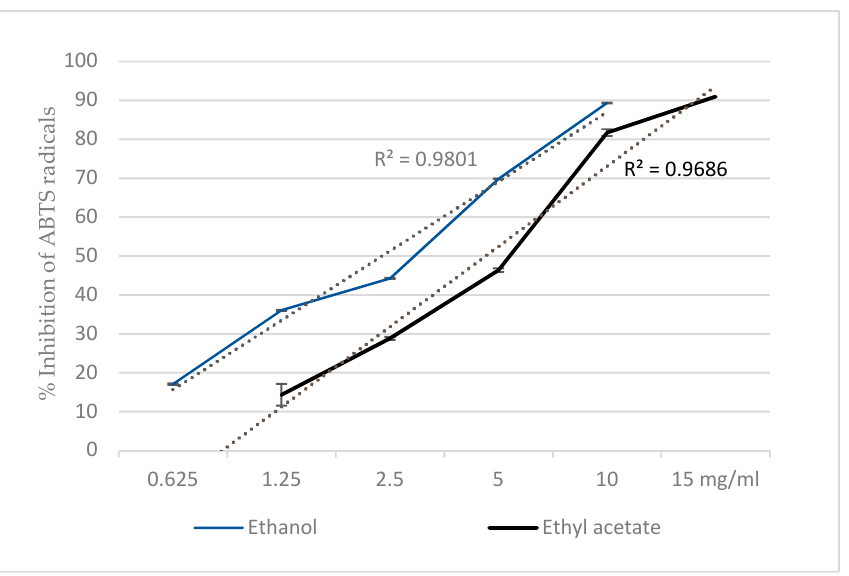
Figure 1. The inhibition of the ABTS radicals of the crude extracts of the banana inflorescence.